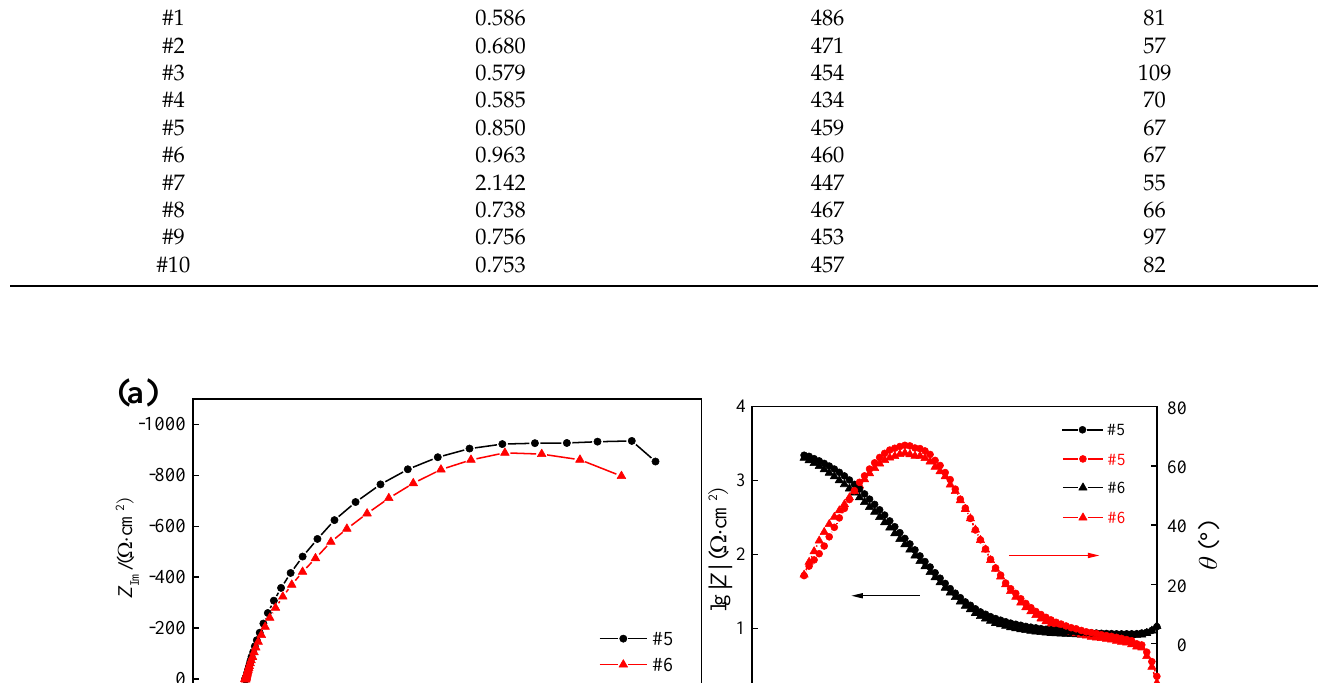
Figure 16. Polarization curves of samples obtained in comparative experiments: ( a ) #5 and #6, ( b ) #1 and #10, and ( c ) #9 and #10.